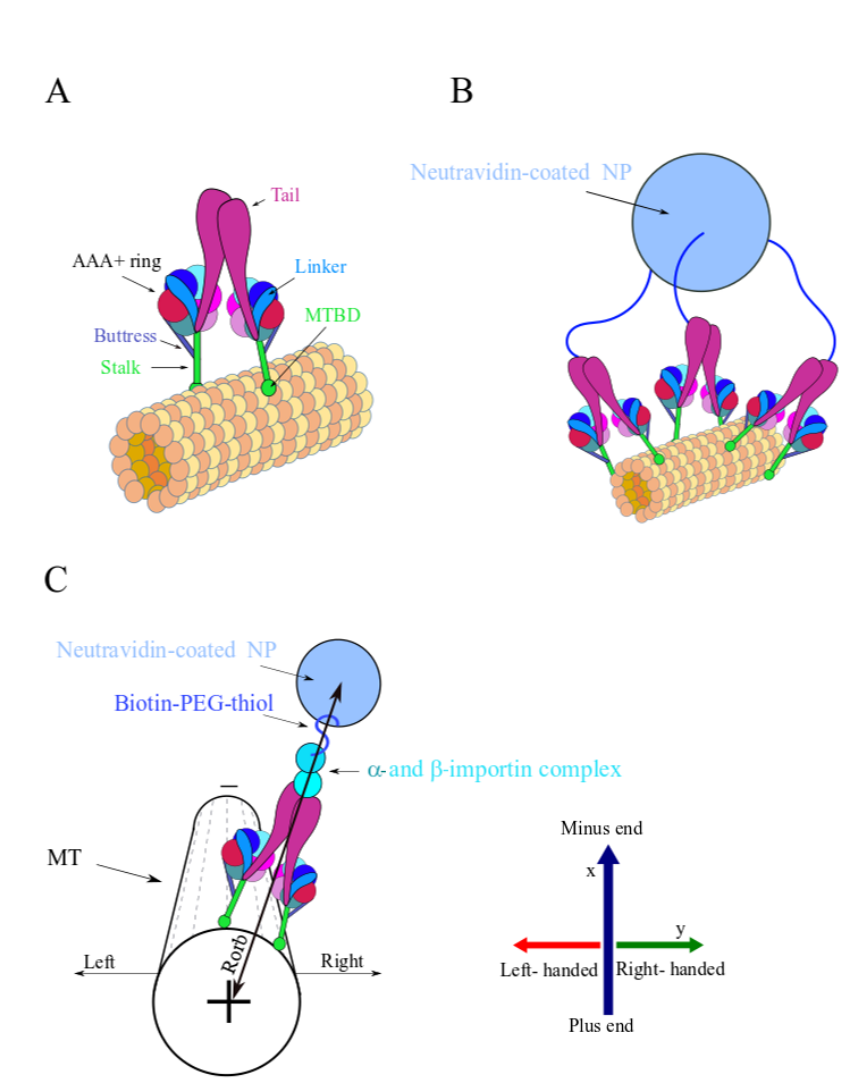
Figure 2. Illustration of single dynein and multi-motor NP (not to scale). Some biological factors, such as dynactin and adaptors, are not shown although they are necessary for the activity of the motor. ( A ) Single dynein motor-protein bound to the MT surface. The MT protofilaments and the corresponding α and β tubulin subunits are represented by the collection of orange and yellow spheres. Color coding: linker (light blue), tails (magenta), the stalks and microtubule binding domains (MTBD) (green), buttress (blue), and the AAA+ ring (red). ( B ) A simplified illustration of an NP with three anchored PEG polymers over its surface, each of which is connected to a single dynein. The Neutravidin-coated NP is represented by a light-blue sphere and the PEG polymers are represented by the blue curved lines. ( C ) Illustration of the spatial orientations used throughout the article to characterize NP motion, i.e., longitudinal motion towards the MT plus- or minus-end and left or right transverse motion with respect to the MT long axis. The Neutravidin-coated NP color code is as in ( B ); the α - and β -importin complex is also shown. The MT is presented with fewer details, where the dashed lines represent the MT protofilaments. Note that the longitudinal axis is denoted by x throughout the text and the transverse axis is denoted by y ; positive and negative x correspond to MT minus- and plus-end directions, respectively. Positive y is the right direction and negative y is the left